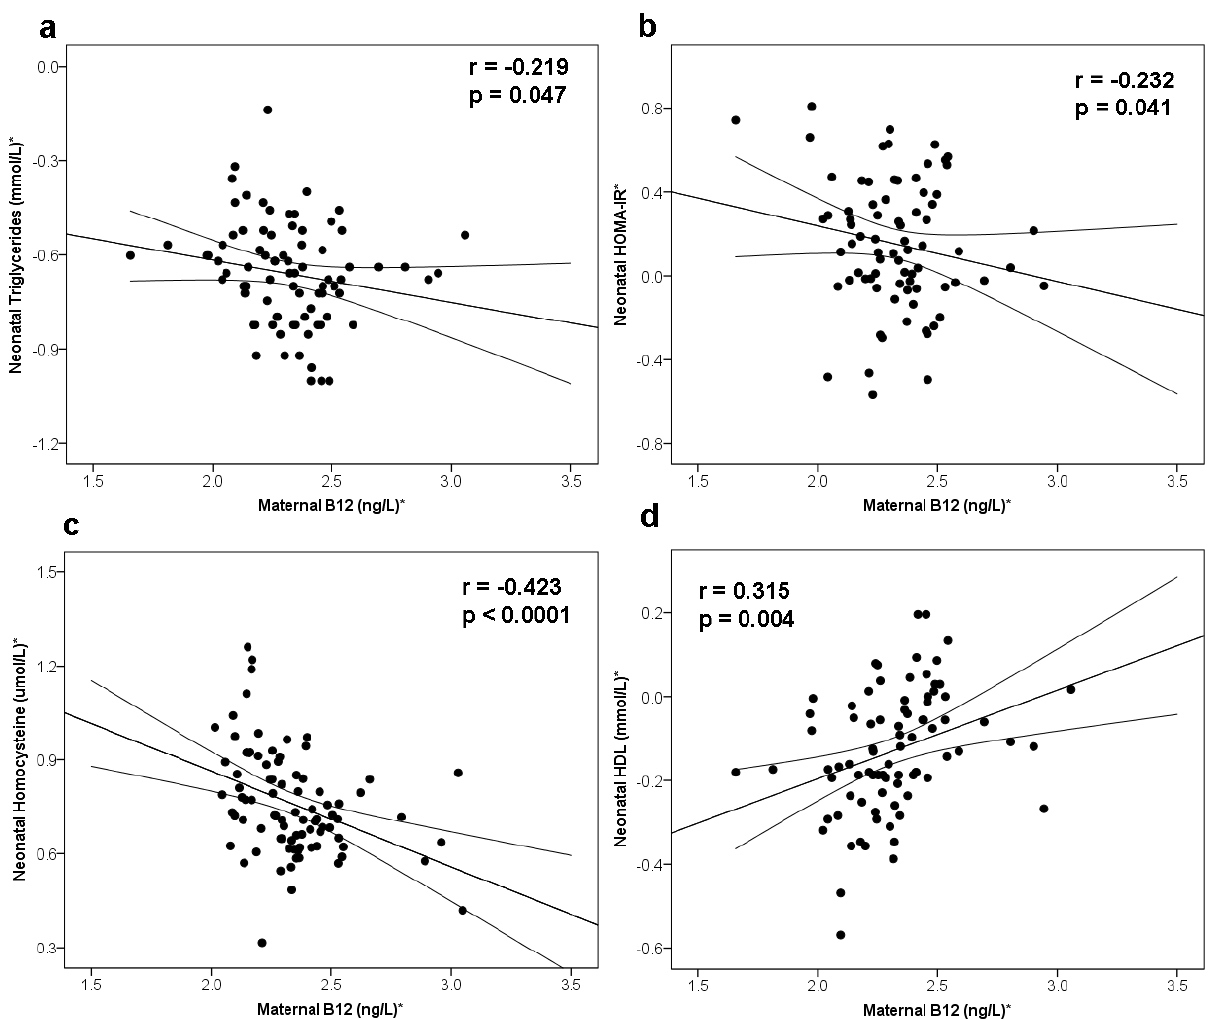
Figure 1. Correlation between maternal B12 (adjusted for age and BMI) and metabolic risk factors of neonates. ( a ) Maternal B12 and neonatal triglycerides, ( b ) Maternal B12 and neonatal Homeostasis Model Assessment 2-Insulin Resistance (HOMA-IR), ( c ) Maternal B12 and neonatal homocysteine, ( d ) Maternal B12 and neonatal HDL. * Log-transformed for statistical